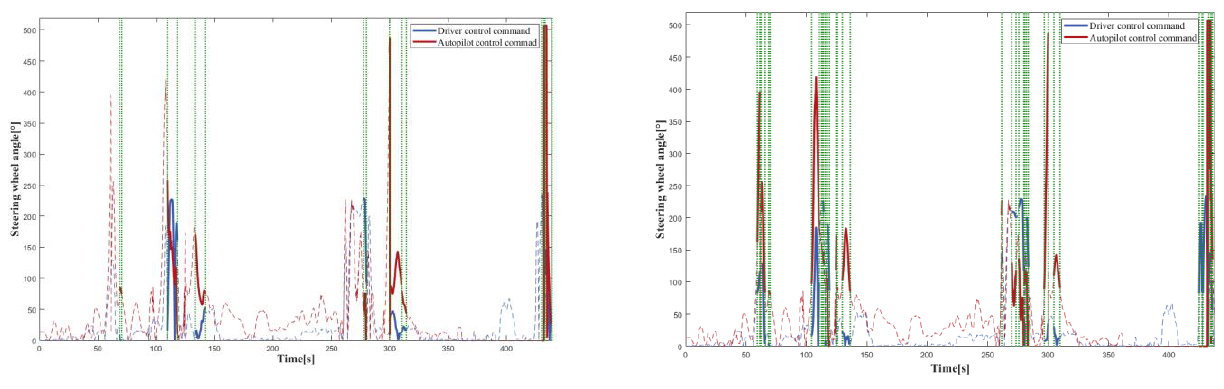
( b ). Trigger based on the instantaneous discrepancy value. Figure 14. The 2nd round test results for lateral control command discrepancy data trigger recording. 4.2. Real Vehicle Tests In order to confirm the proposed model’s effectiveness in the real world, it was configured in the vehicle IPC, and Simulink software was employed to communicate with the ROS system to attain real-time discrepancy detection and data-trigger recording in the real vehicle. According to the experimental findings, the control commands output of the driver and the ACC algorithm were plotted versus time, where the dashed line is all the data during the test, and the solid line is the data recorded by the system after applying the discrepancy trigger model, using a vertical green dashed line to distinguish the two. As depicted in Figure 15, the findings demonstrated that the suggested model was equally efficient in the real world. This satisfied the real-time requirements for online operating in real-time for the onboard IPC, and the discrepancy trigger model, when operating on the real vehicle, was also capable of precisely detecting the existence of different or opposite trends in the control commands of the driver and the autopilot algorithm and recording the significant data completely.